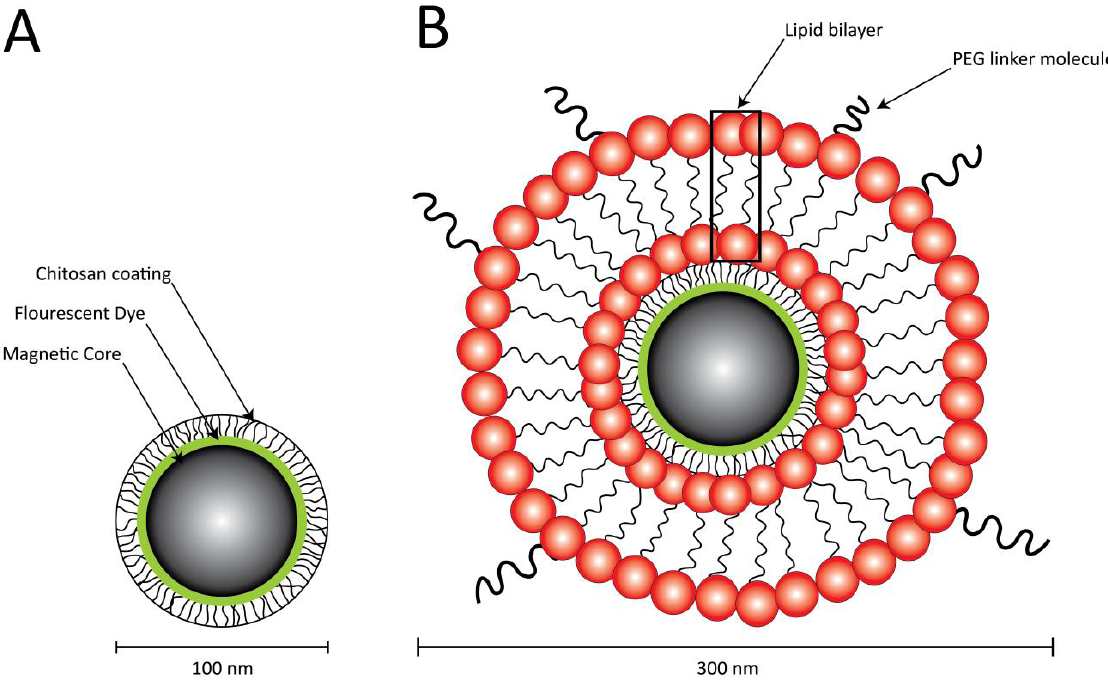
Figure 1. Principal structure of the two magnetic nanoparticles (MNPs) used in the present study. ( A ) The chi-MNP consists of a magnetic iron-oxide core covered by a lipophilic green fluorescent dye and a second layer of chitosan coat that prevents aggregation with other MNPs; ( B ) The lip-MNP is made from the chi-MNP by encapsulation inside a liposome. The liposomes were additionally PEGylated for use in vivo